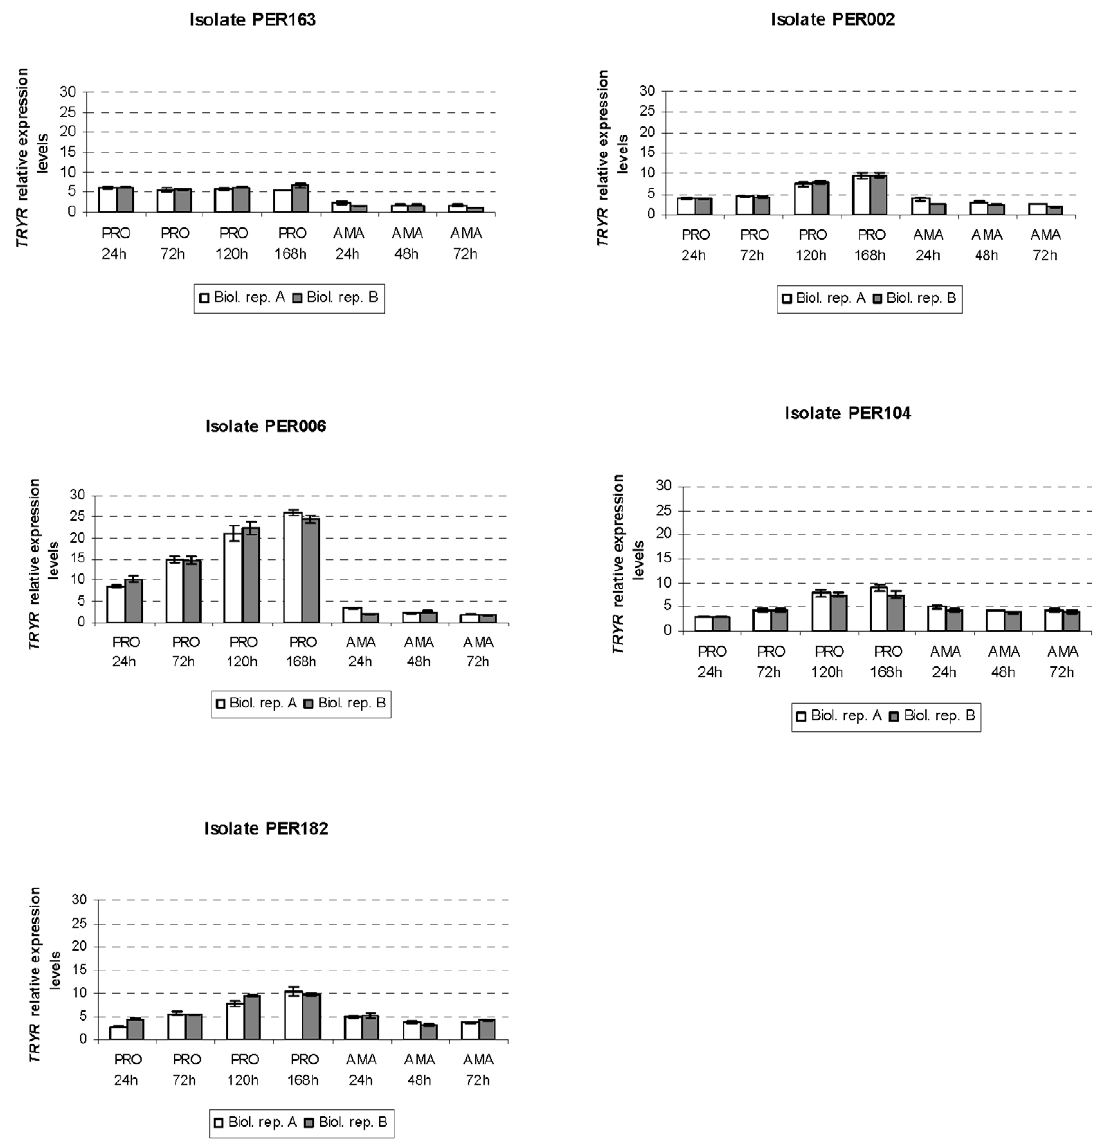
Figure 3. Variation in TRYR gene expression throughout invitro growth and differentiation of promastigotes and intracellular amastigotes of L.braziliensis isolates studied (see legend of figure 2).